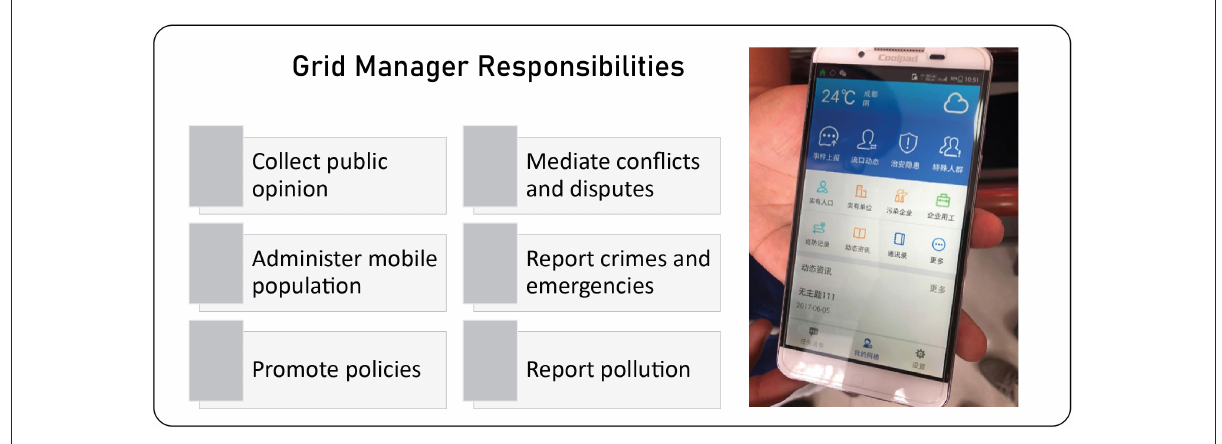
FIGURE3 Grid manager main responsibilities and their smartphone interface (Photograph by author, July